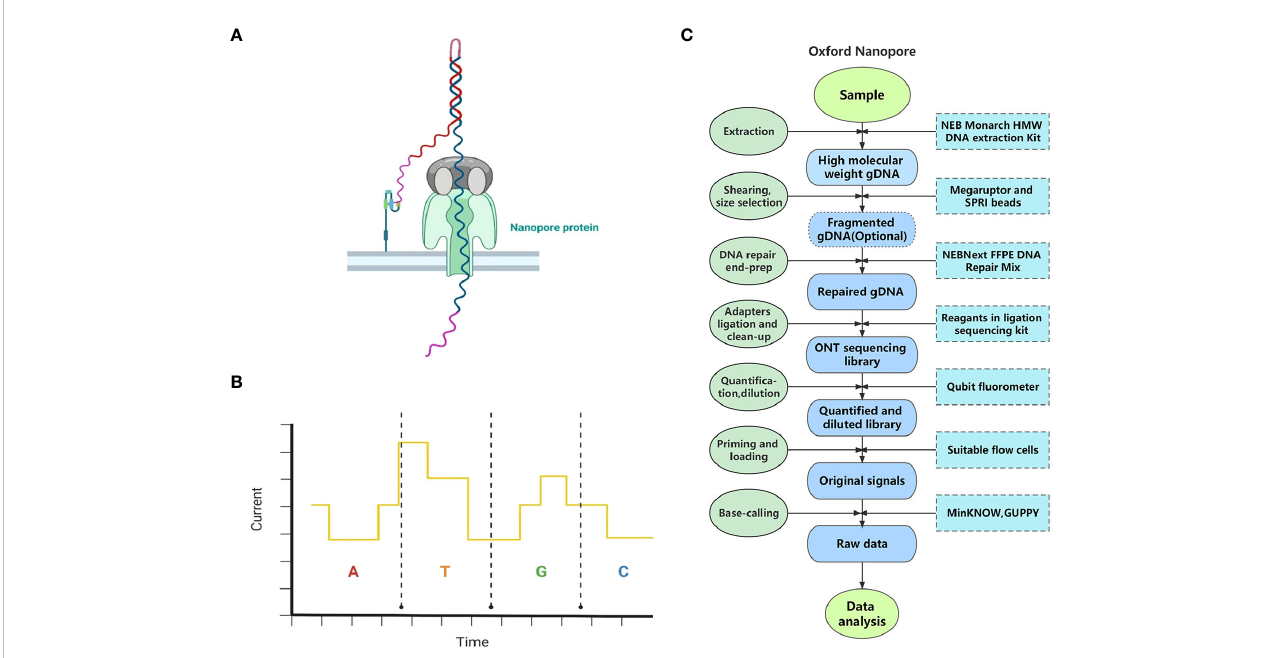
FIGURE 2 The principle and pipeline of Oxford Nanopore Technology. (A) The speci fi c scene of threading a single-stranded DNA through a nanopore protein. (B) Different dNTPs can cause distinct interference to the current when passing through the nanopore protein (the current variations demonstrated do not represent the true in fl uence of dNTPs.) (C) The pipeline of Oxford Nanopore